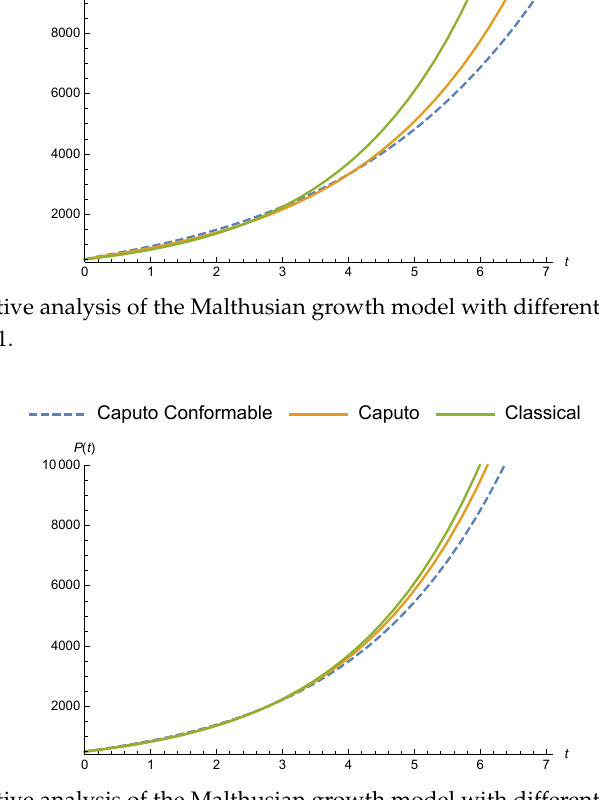
Figure 8. Comparative analysis of the Malthusian growth model with different types of derivatives while α = β =